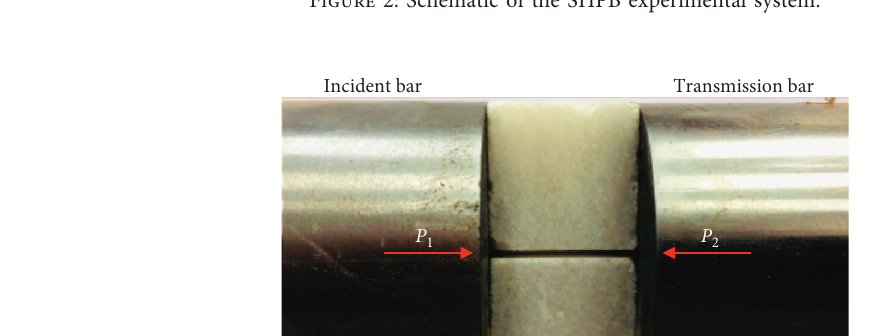
Figure 2: Schematic of the SHPB experimental system.